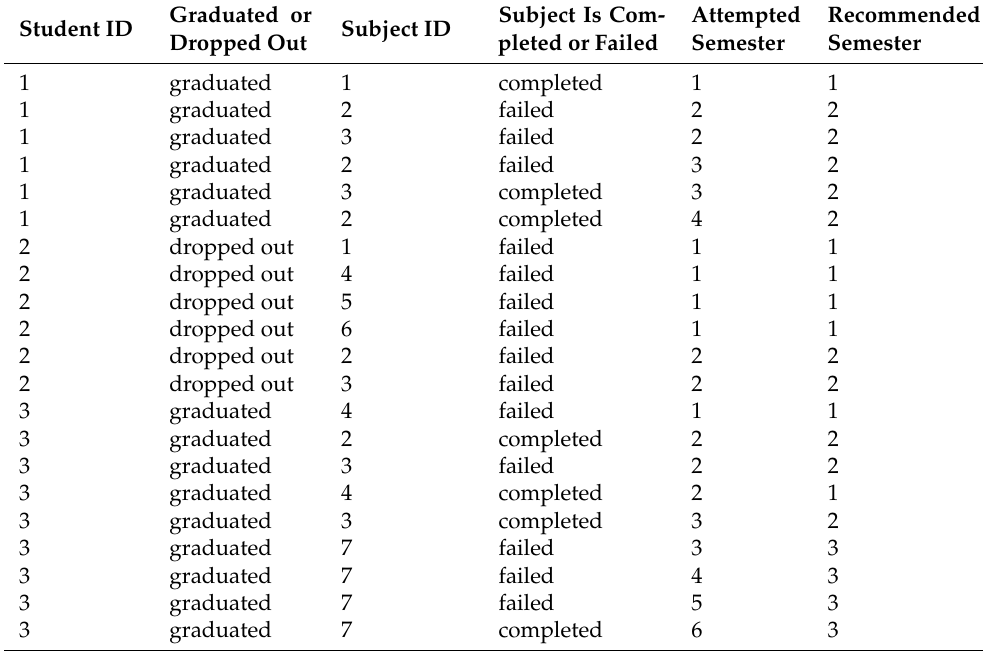
Table 1. A sample for the student log file which integrates the student-specific data and the sample